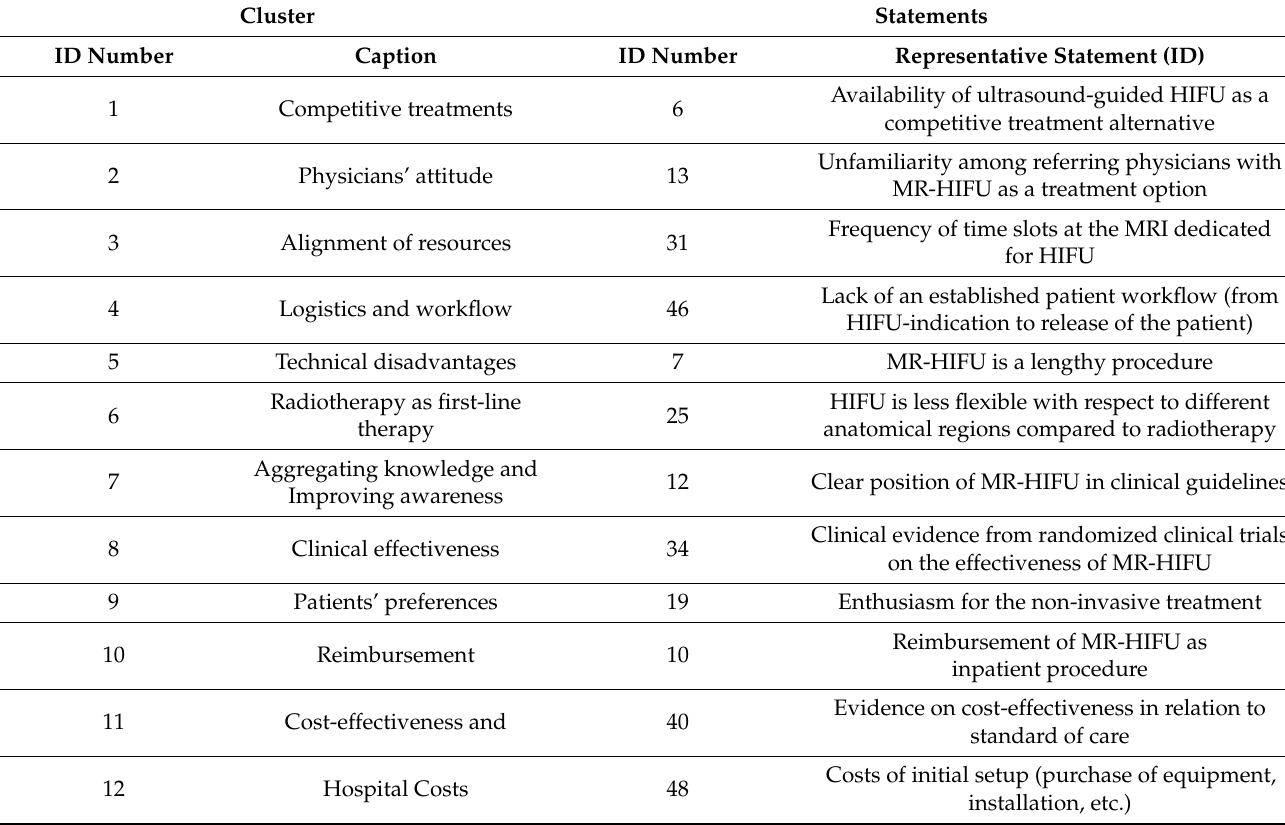
Table 2. Representative statements for each cluster.